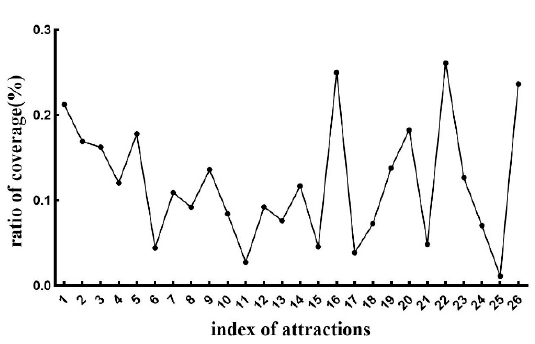
Figure 10. Coverage of the travel networks.